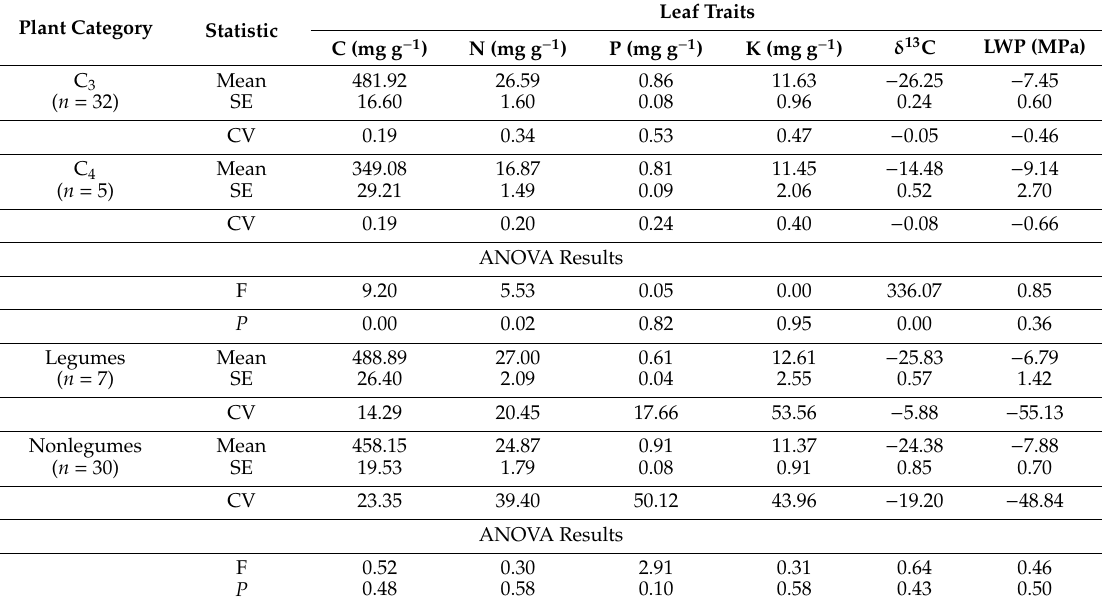
Table 4. Concentrations of analyzed leaf traits: as leaf carbon (C) concentration, leaf nitrogen (N) concentration, leaf phosphorus (P) concentration, leaf potassium (K) concentration, carbon isotope C 13 concentration ( δ 13 C) and leaf water potential (LWP) for C 3 , C 4 , legumes and nonlegumes species.